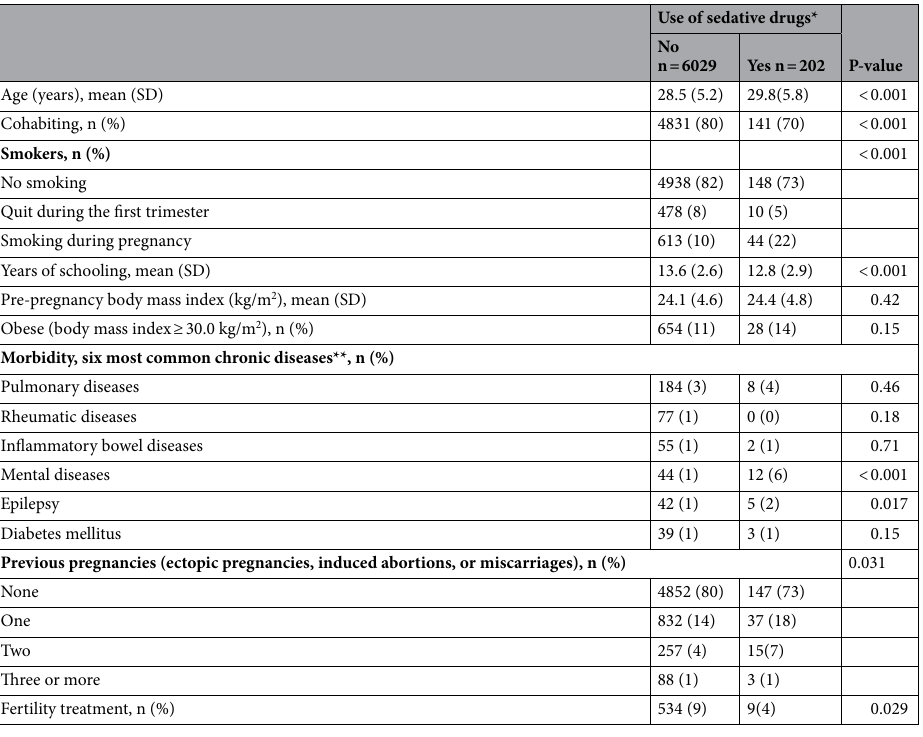
Table 1. Characteristics of the 6231 primiparous women divided into users of sedative drugs and non-users. SD standard deviation. *Women who had prescription drug purchase with Anatomical Therapeutic Chemical (ATC) codes N03AE (clonazepam), N05BA (benzodiazepine derivatives anxiolytics), N05CD (benzodiazepine derivates), or N05CF (benzodiazepine related drugs) within 90 days before conception, during pregnancy, or within 90 days after delivery were considered as users of sedative drugs. **Data on morbidity based on the register of reimbursement rights for chronic diseases kept by Social Insurance Institution,